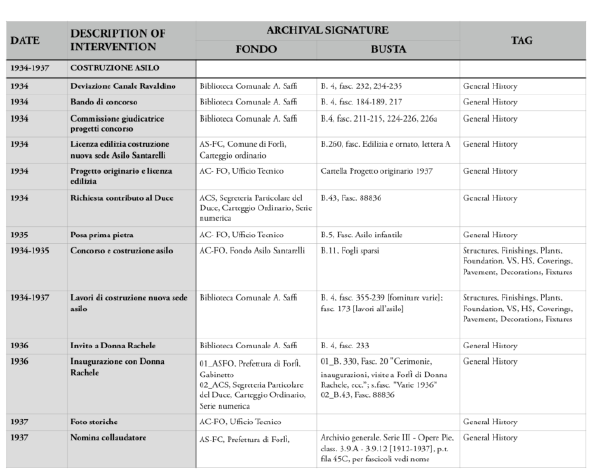
Figure 4. Santarelli kindergarten. Matrix extrapolated from